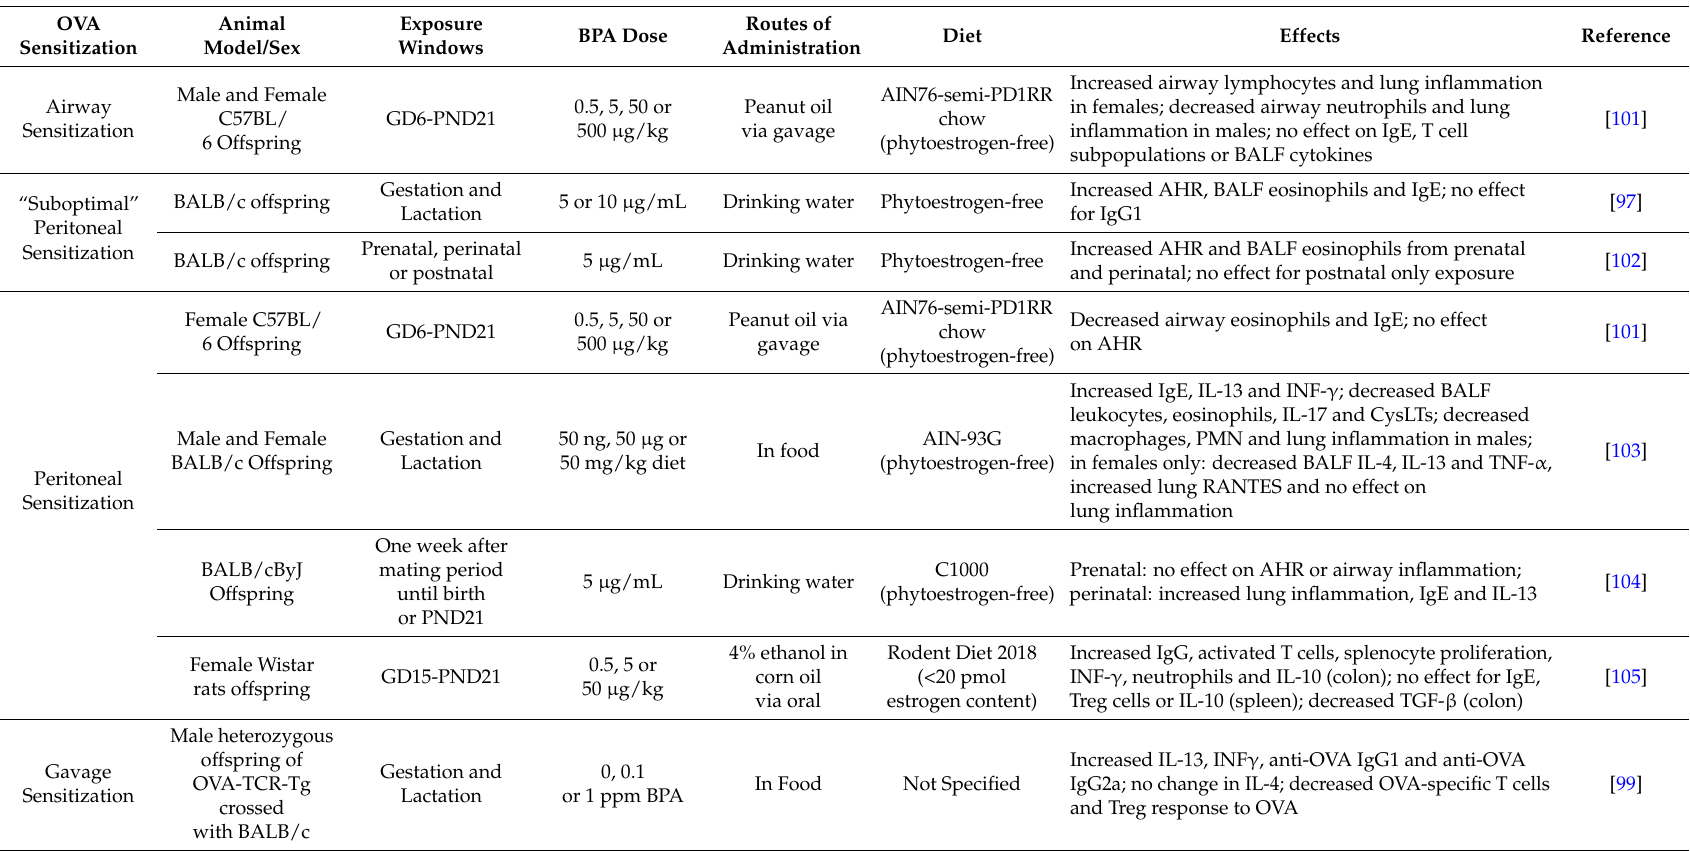
Table 3. Summary of allergy/asthma animal studies on BPA exposed